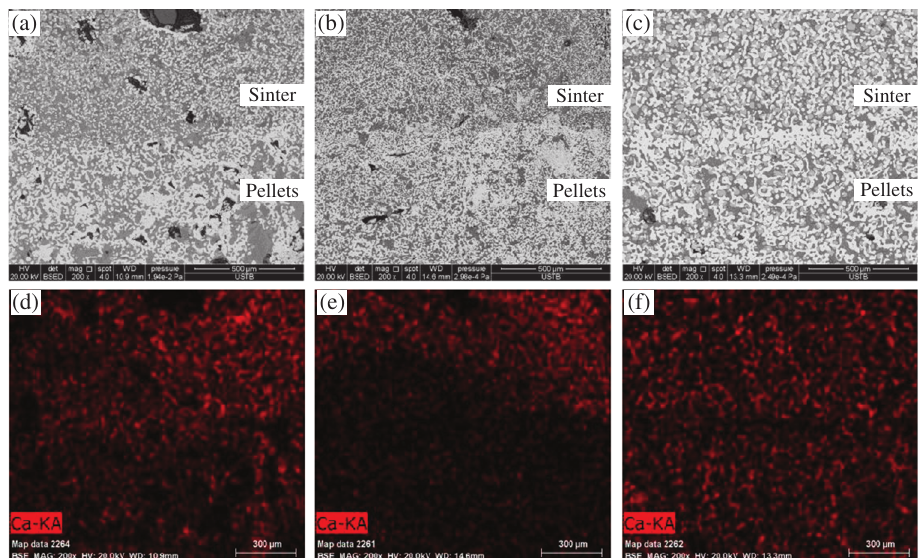
Figure 14: The microstructure in the interface of pellet and sinter particles. (a)